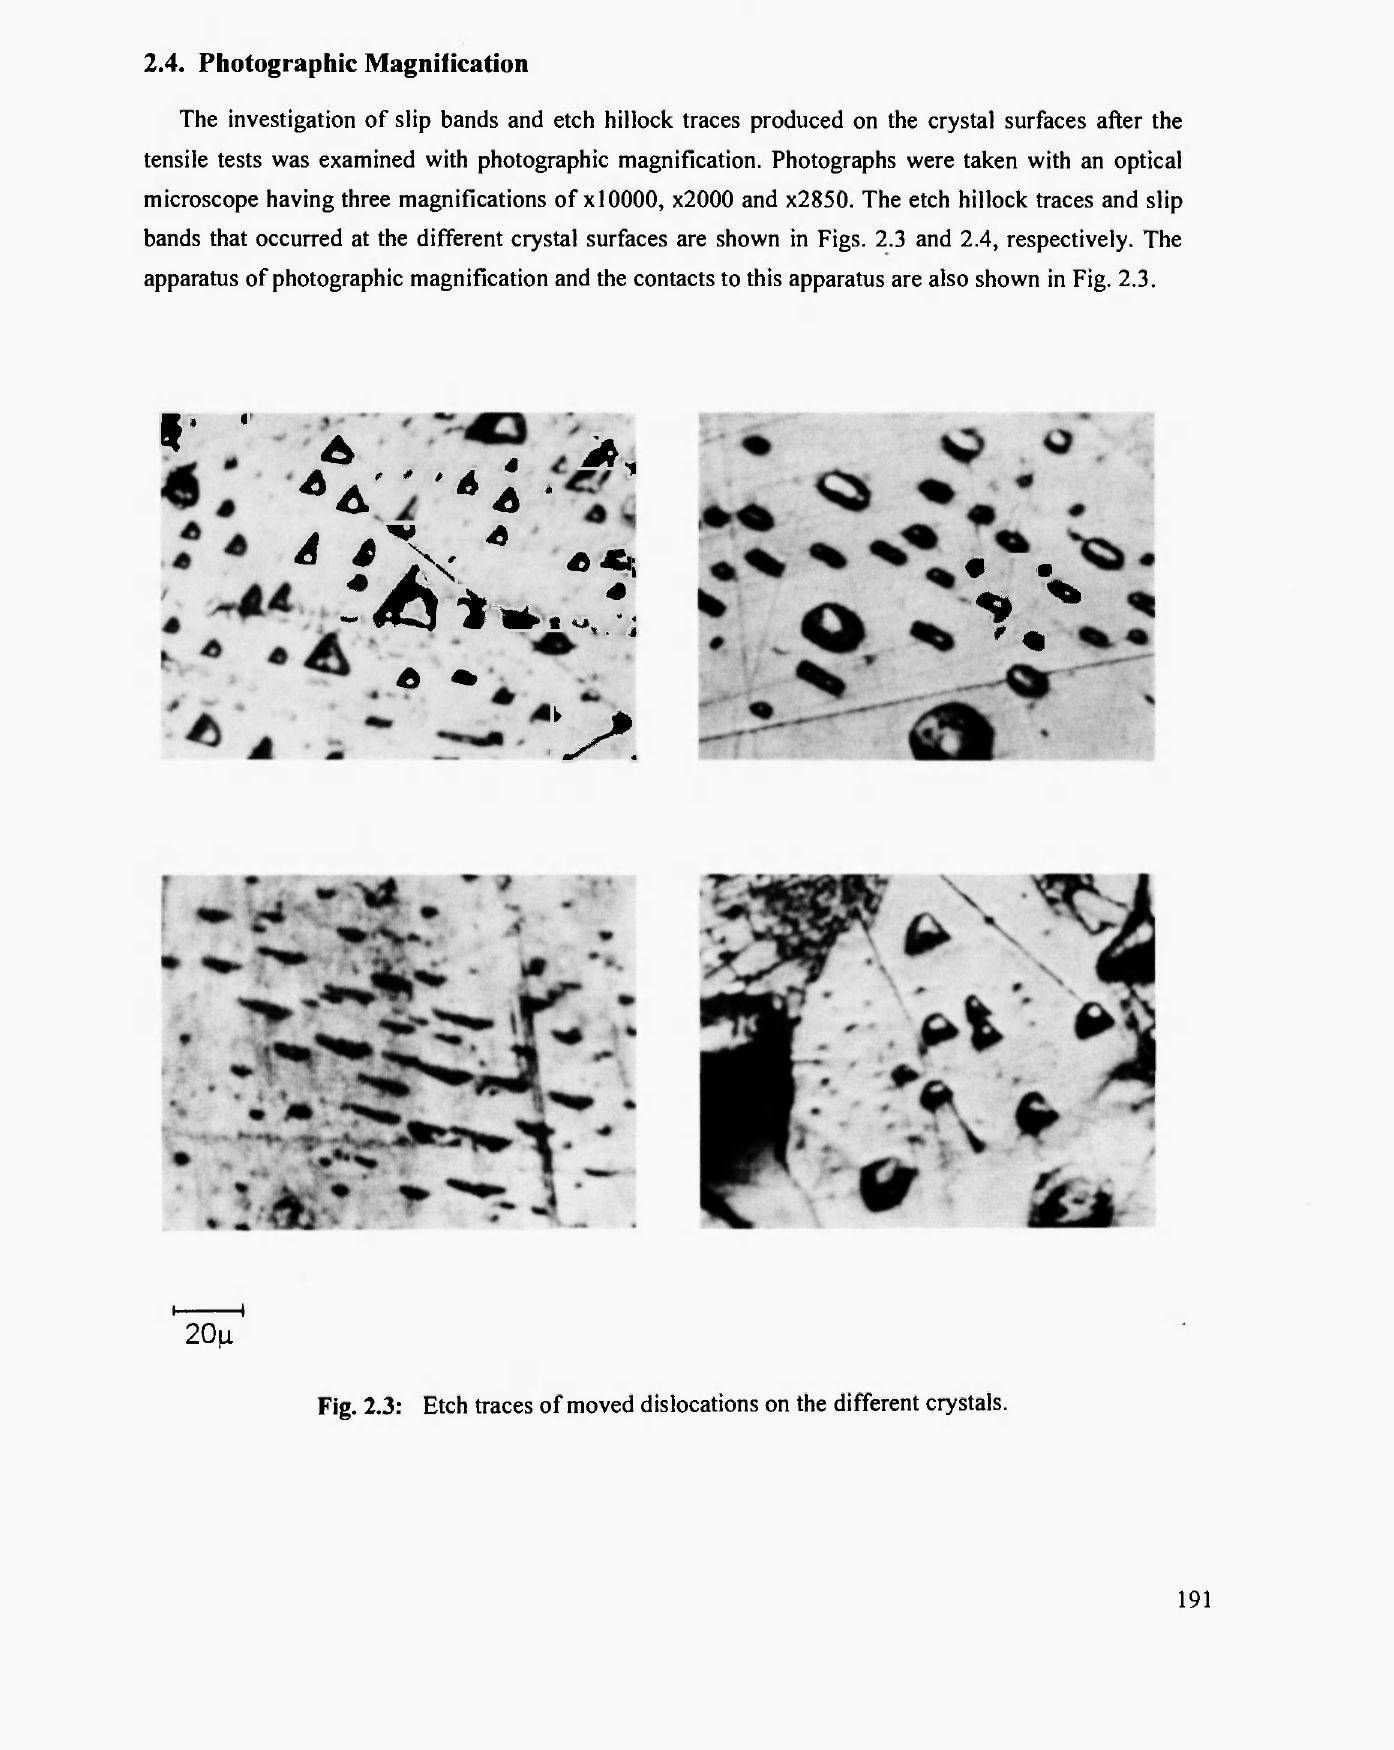
Fig. 2.3: Etch traces of moved dislocations on the different